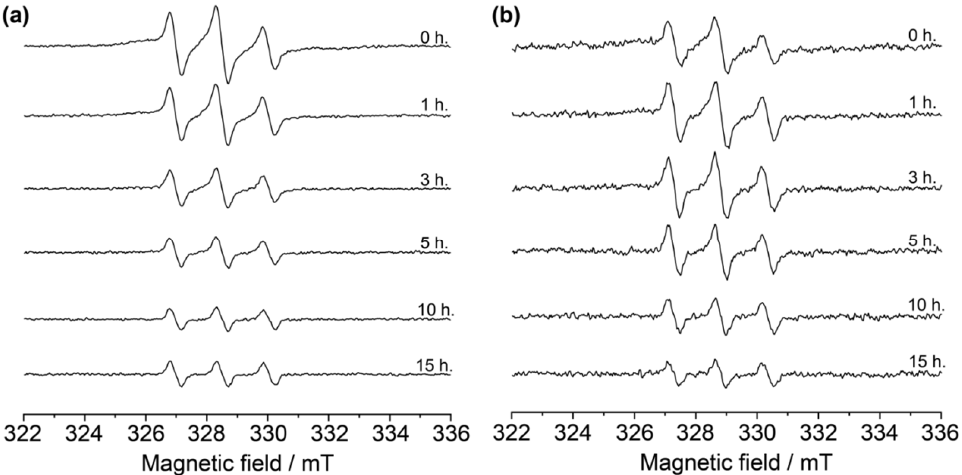
Figure 6. EPR spectra of A549 cells after their 1 h incubation with 1.34 µ M sRL2 (molar ratio of spin label 1 to RL2 2 : 3.5) without ( a ) and with ( b ) the addition of 1% NaN 3 , recorded at different time points after the incubation. The zero time point corresponds to the start of EPR spectra acquisition. Initial spin concentrations observed by EPR at the zero time point for these two samples were 87 µ M ( a ) and 16 µ M ( b ). The spectra were acquired at 35 ◦ C with the following parameters: microwave frequency ( a ) 9.230945 GHz, ( b ) 9.234907 GHz; ( a , b ) microwave power 2.0 mW; conversion time ( a , b ) 19.56 ms; sweep time ( a , b ) 10.01 s; time constant ( a , b ) 20.48 ms; ( a , b ) 512 points; number of scans ( a ) 32 or ( b ) 64. In both cases, the external magnetic field was modulated at frequency 100 kHz and modulation amplitude 0.2 mT.